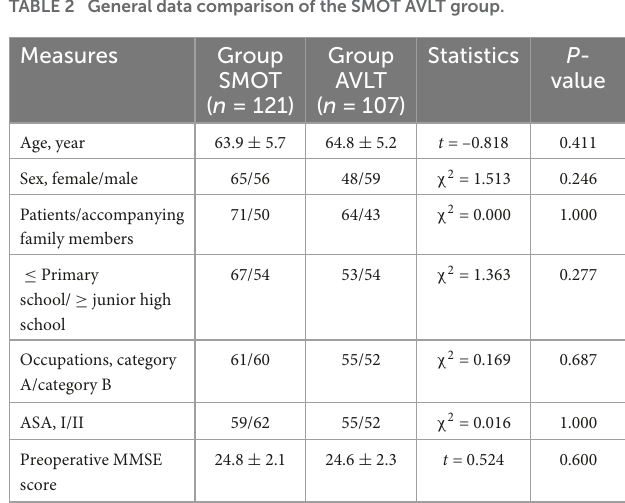
TABLE 2 General data comparison of the SMOT AVLT group.